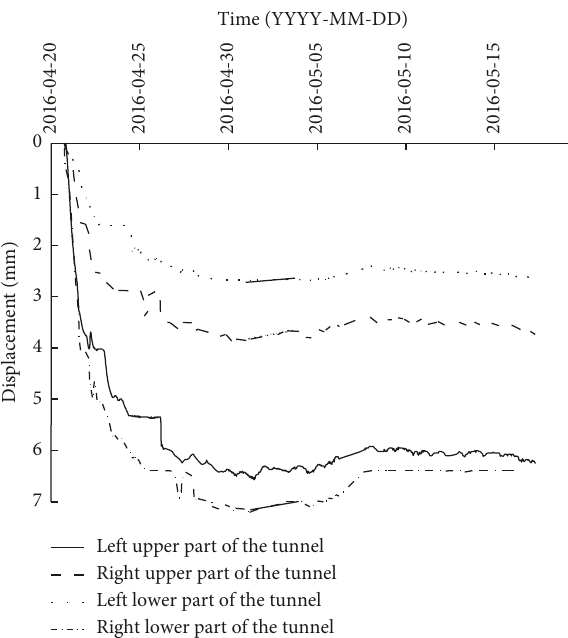
Figure 10: Displacement-time curves of the surrounding rock at the cross section of ZK52+888.